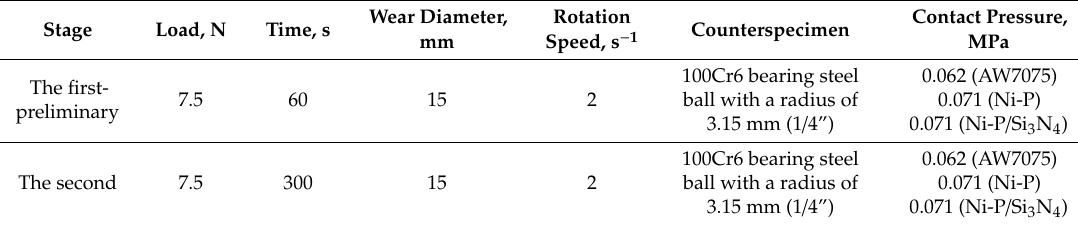
Table 2. Parameters of tribological tests (the first step).